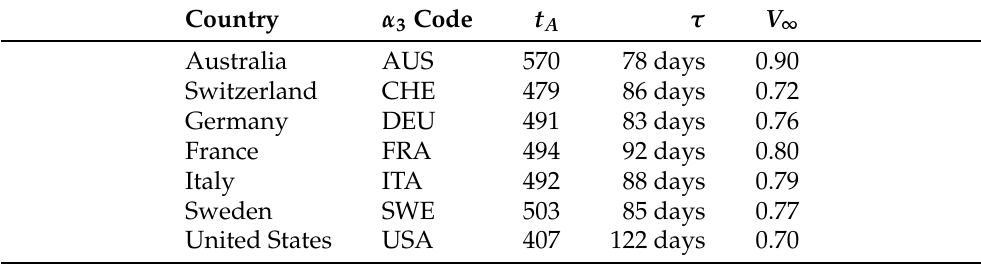
Table 1. Effective vaccination onset t A , relaxation time τ and final fraction of fully vaccinated persons V ∞ obtained using Equations (25) and vaccination data shown in Figure 4; t A is specified in number of days after 1 January